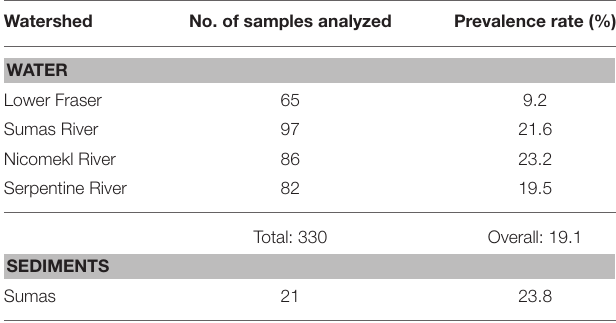
TABLE 1 | Numbers of water and sediment samples analyzed and STEC prevalence rates in four watersheds of the Lower Mainland of British Columbia between November 2012 and November